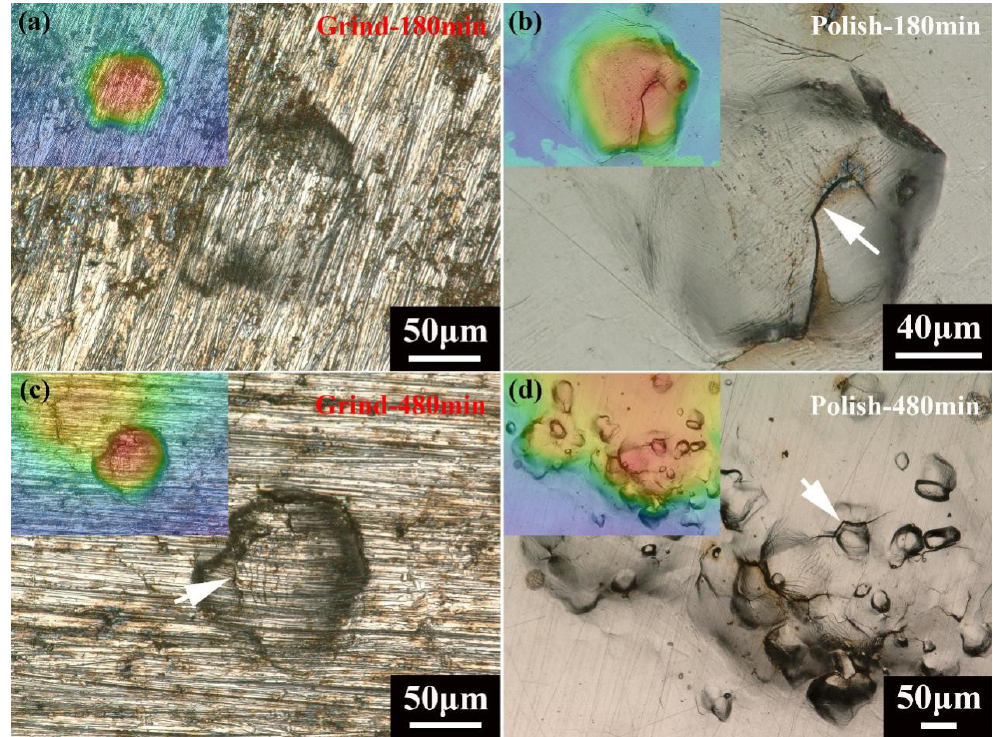
Figure 6. Blister high magnification images of grinded and polished surfaces at various hydrogen charging times. ( a ) grind-180 min; ( b ) polish-180 min; ( c ) grind-480 min; ( d ) polish-480 min. Left upper corner images showing corresponding blister height profile. The red color indicating high position and the blue color indicating low position. White arrowhead indicating cracks on the blisters.